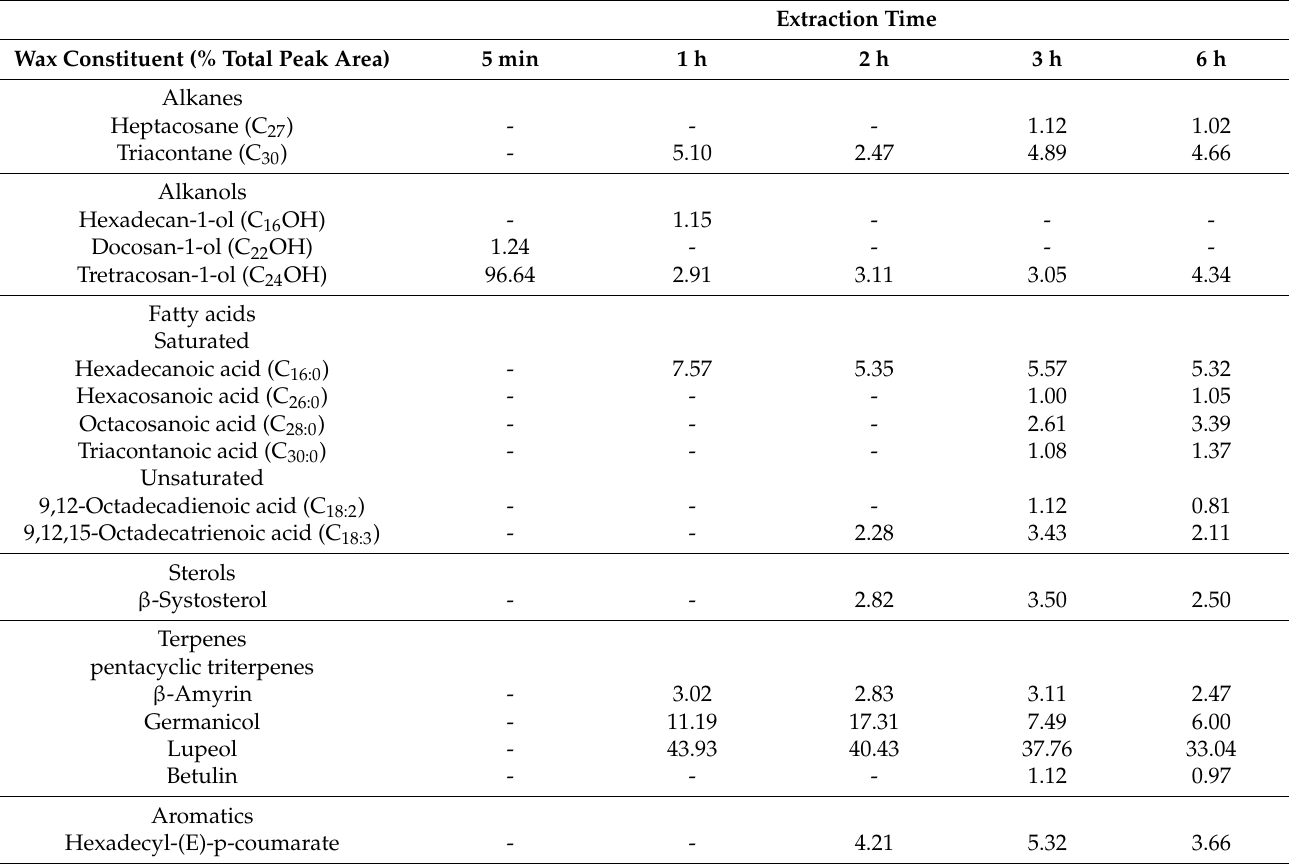
Table 3. Composition of the cuticular waxes of cork oak leaves solubilised by n-hexane with different extraction times, as determined by GC–MS, in % of total peak area (only compounds with over 1% are shown; complete composition in Supplementary Table